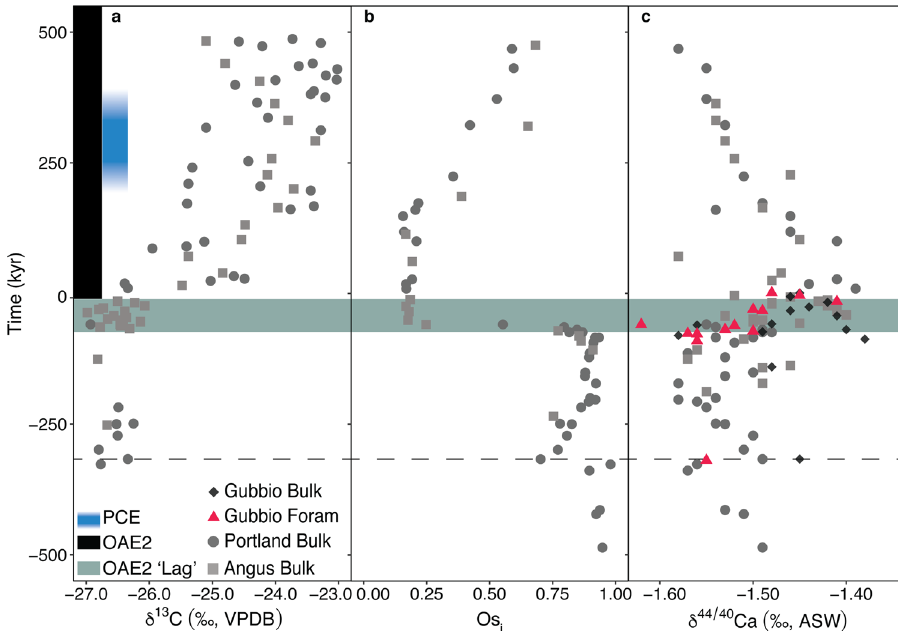
Fig. 4 A compilation of geochemical data preceding and across OAE2. Time series of a carbon isotope ( δ 13 C) values from two sites, the AA core in gray squares (Joo and Sageman 45 ) and the Portland core in gray circles (Sageman et al. 17 ), b osmium isotope (Os i ) from two sites, the AA core in gray squares (this study) and the Portland core in gray circles (Du Vivier et al. 35, 36 ), and c calcium isotope values from three sites: the Gubbio Bottaccione section with foraminiferal measurements in red triangles and bulk carbonate in black diamonds (this study), the AA core in gray squares (this study), and the Portland core in gray circles (Du Vivier et al. 30 ). The gray shaded area marks the previously observed lag between the Os i excursion indicating enhanced volcanism and the onset of the positive δ 13 C excursion marking greater organic carbon burial 36 , which corresponds to the lower critical interval. The dashed line marks a small decrease in Os i and a small increase in δ 44/40 Ca at roughly 300 kyr before OAE2 began. The timing of the Plenus Cold Event, shown with blue shading, follows from O ’ Connor et al. 37 . PCE Plenus Cold Event, OAE2 Oceanic Anoxic Event 2, ASW Atlantic Seawater; VPDB Vienna Peedee